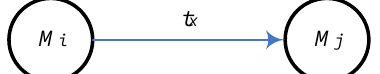
Figure 1. One enabled transition t x between two markings ( M i and M j ) in a reachability graph.